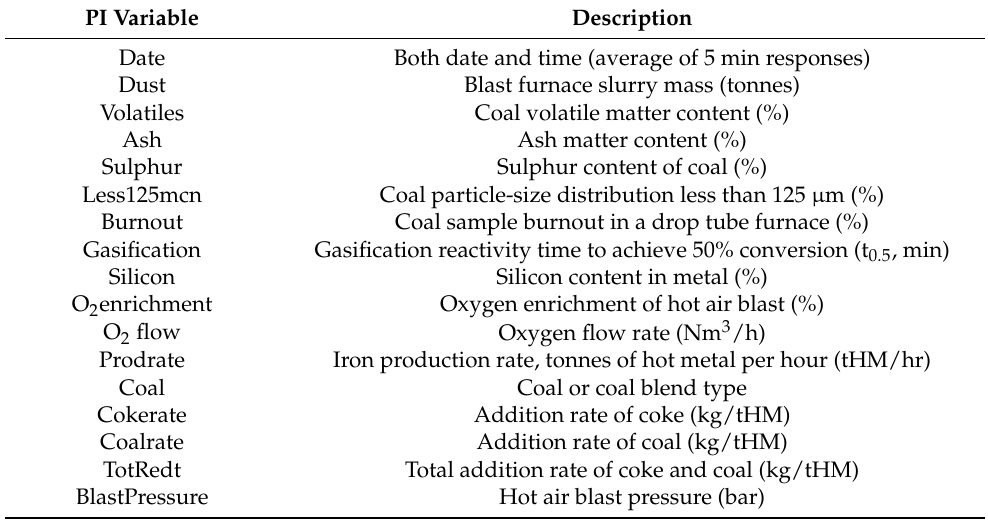
Table 1. Process variables and